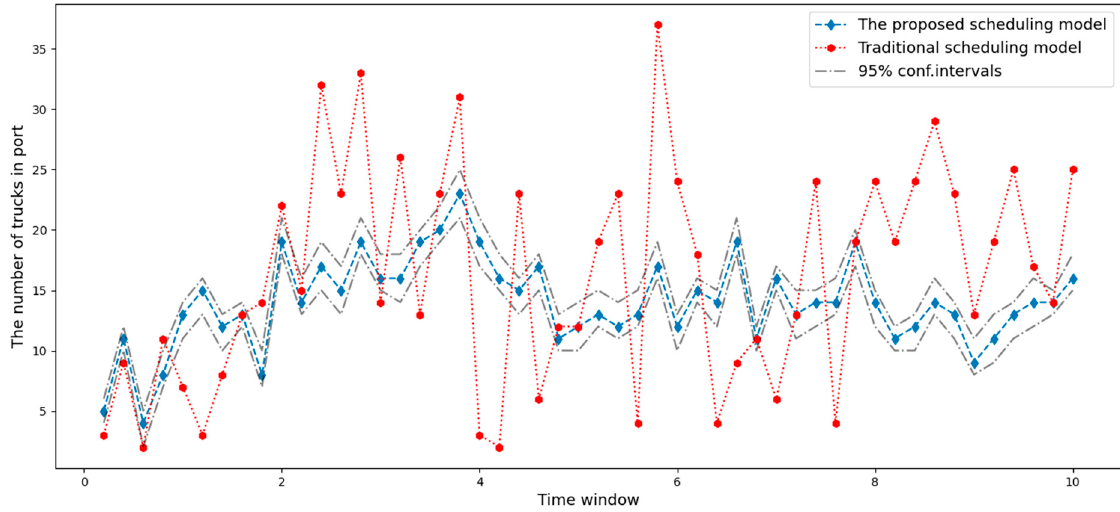
Figure 4. Fitting of experimental results and test results.